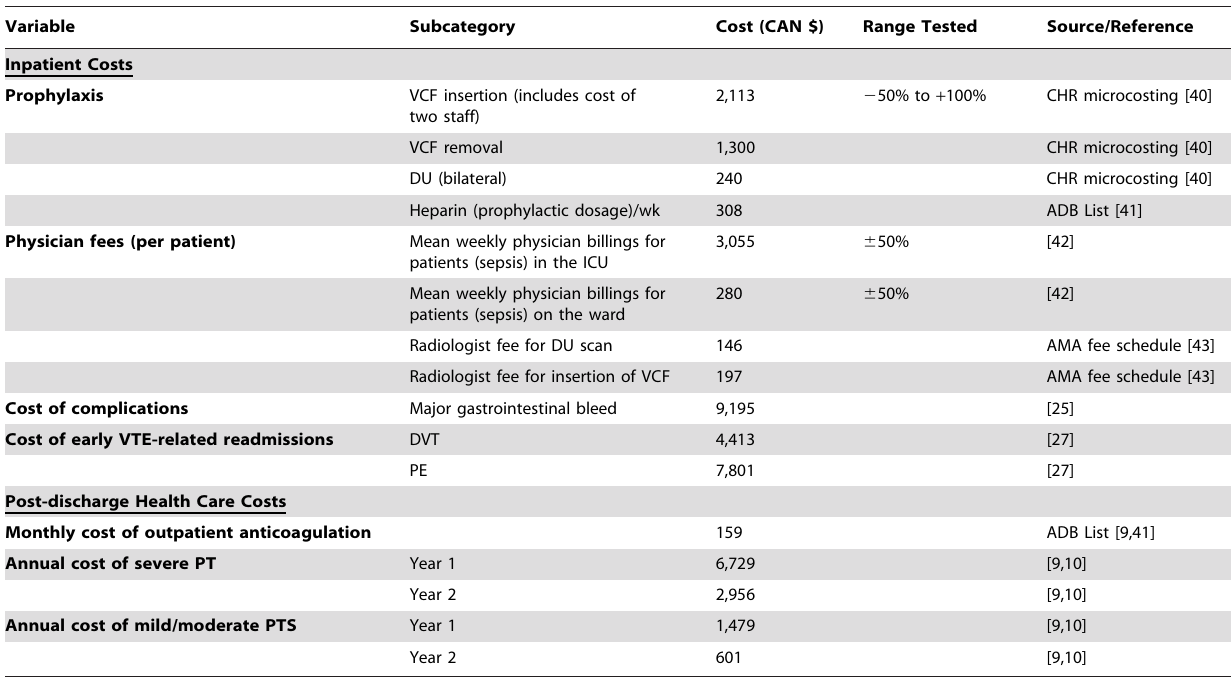
Table 3. Base case patient costing estimates.